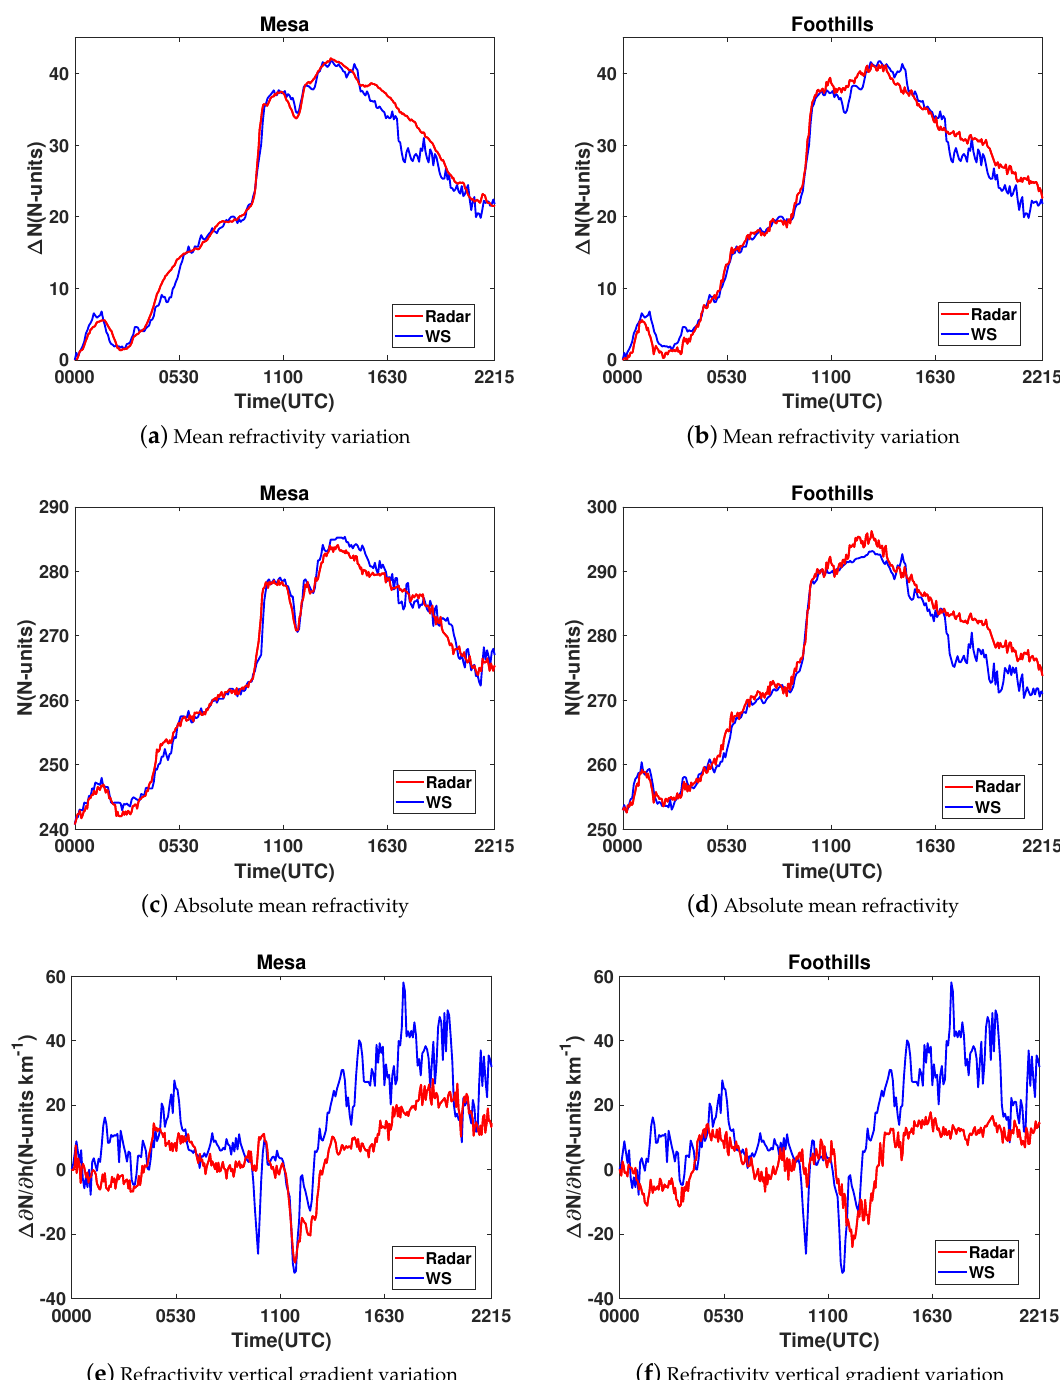
Figure 6. Mean refractivity variation at the radar height, absolute mean refractivity at the weather station heights and refractivity vertical gradient obtained from radar phase measurements (red) and weather stations data (blue) in the Mesa and Foothills